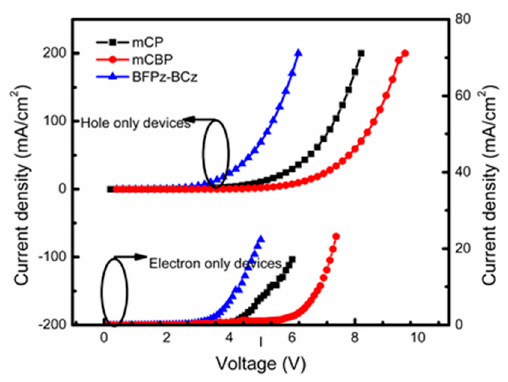
Figure 4. ( a – b ) CE- L and η EQE - L curves of deep-blue devices; ( c – d ) CE- L and η EQE - L curves of white devices. Table 2. Summary of electroluminescence data for organic light-emitting diodes (OLEDs). Devices a